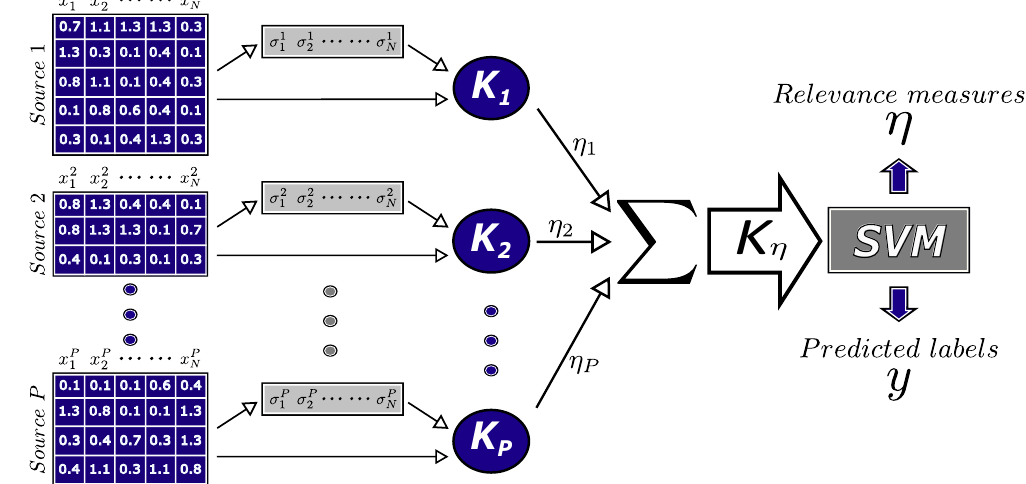
Figure 1. Flowchart of the proposed